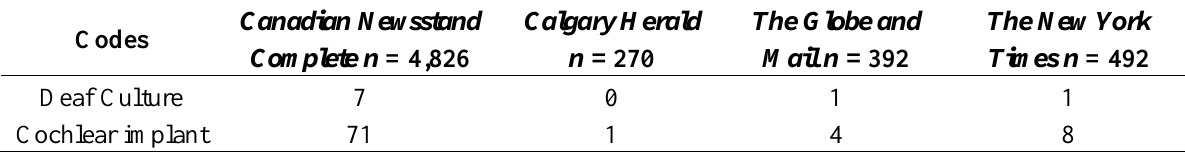
Table 4. Frequency of use of deafness related